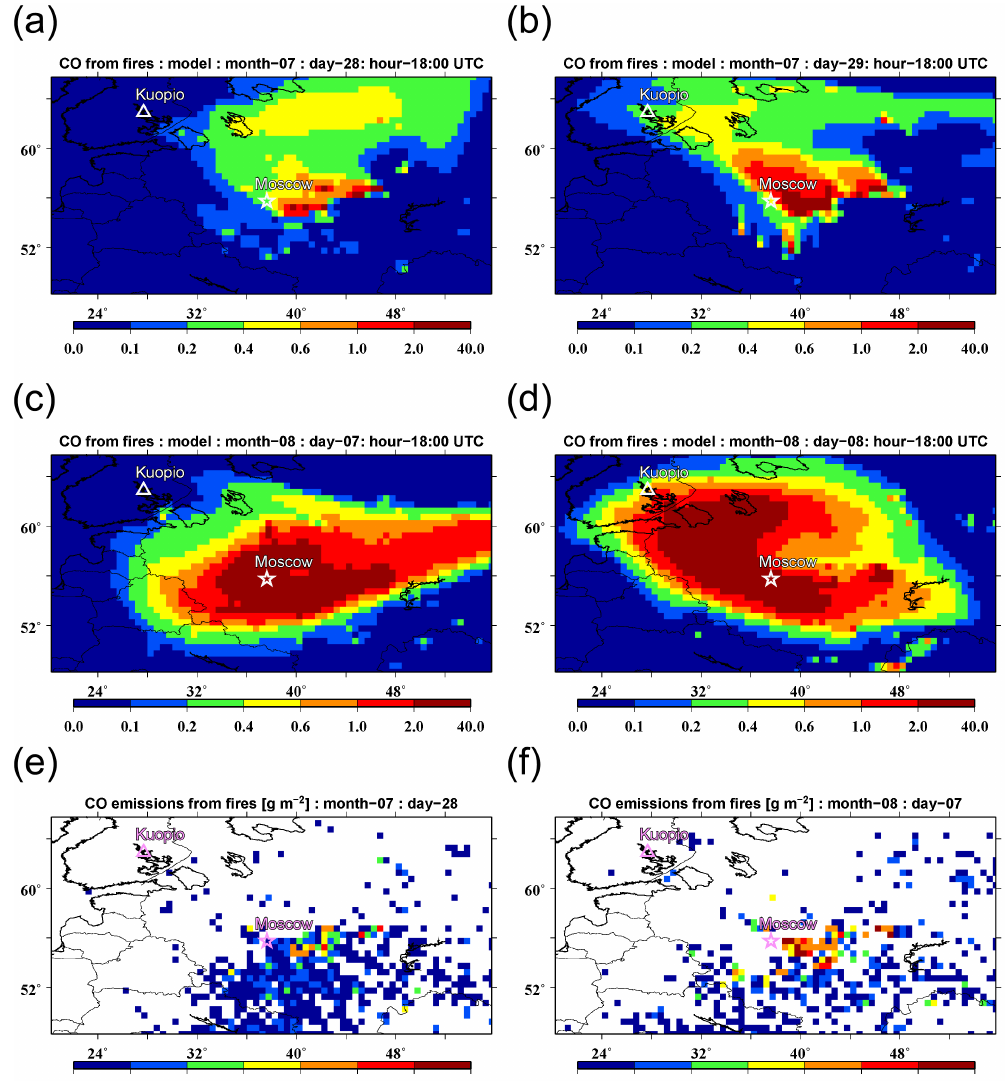
Figure 2. Simulated near-surface concentration (mgm − 3 ) of fire-emitted CO at 18:00UTC on (a, b) 28 and 29 July and on (c, d) 7 and 8 August 2010, respectively, along with spatial distributions of CO amounts (gm − 2 ) emitted from fires on (e) 28 July and (f) 7 August